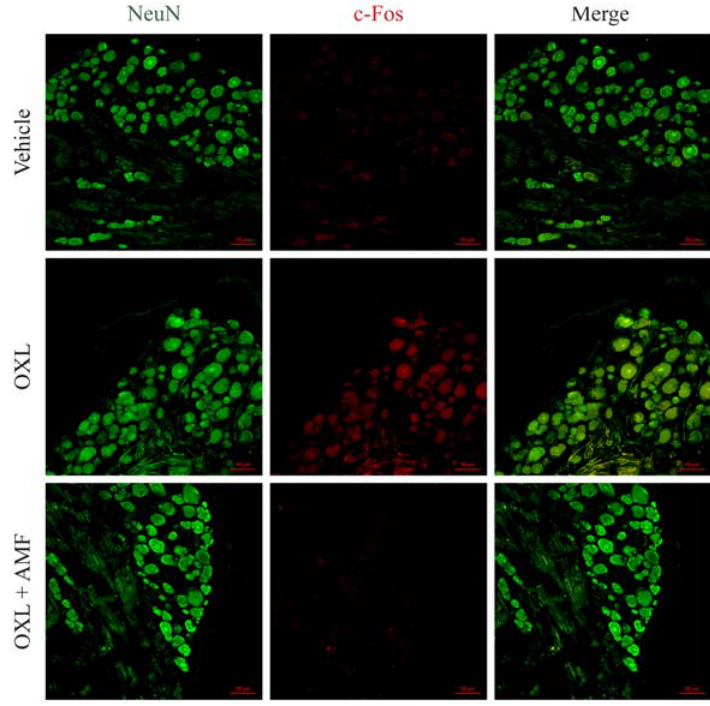
Figure 3. c-Fos expression in the dorsal root ganglia on the 28 th experimental day. Green: neuronal marker (NeuN); red: c-Fos; merge: yellow. Magni fi cation 200 (cid:1) ; scale bar 50 m m. OXL: oxaliplatin; AMF: